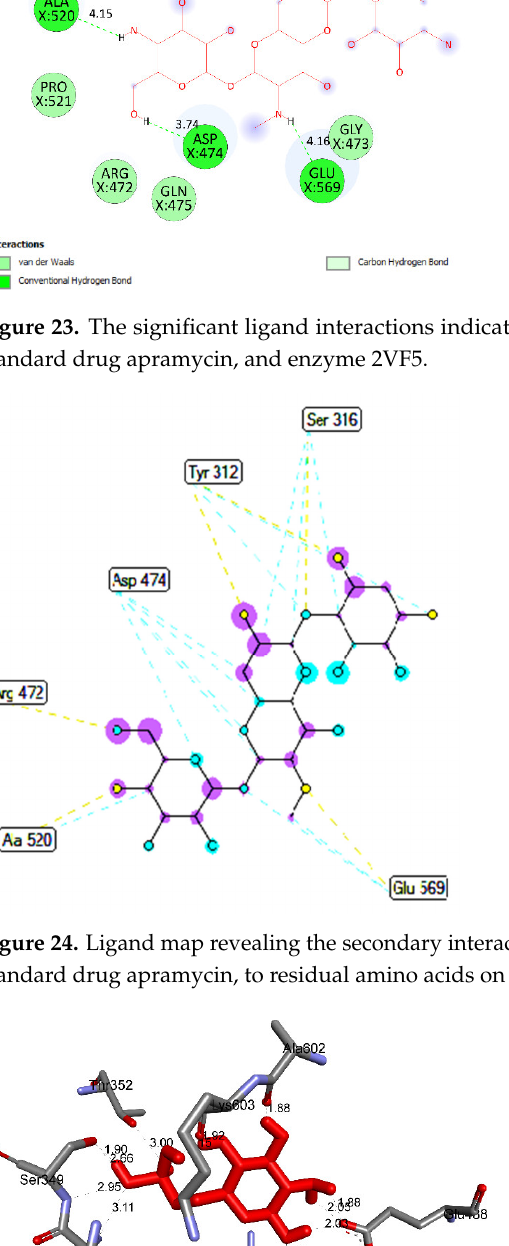
Figure 26. Diagram detailing the significant ligand interactions forming from pose 83, one small ligand, to active atoms on enzyme 2VF5.